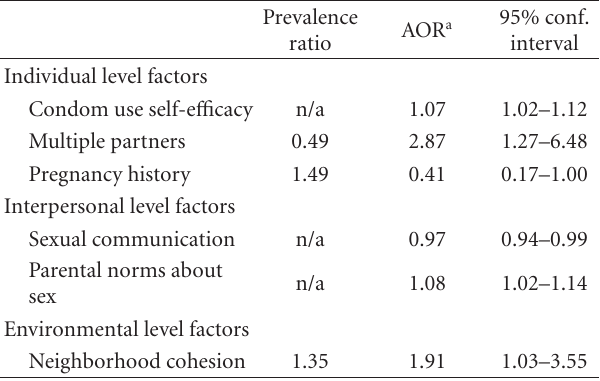
Table 3: Multivariable associations between individual-, interpersonal- and environmental level factors and multimethod